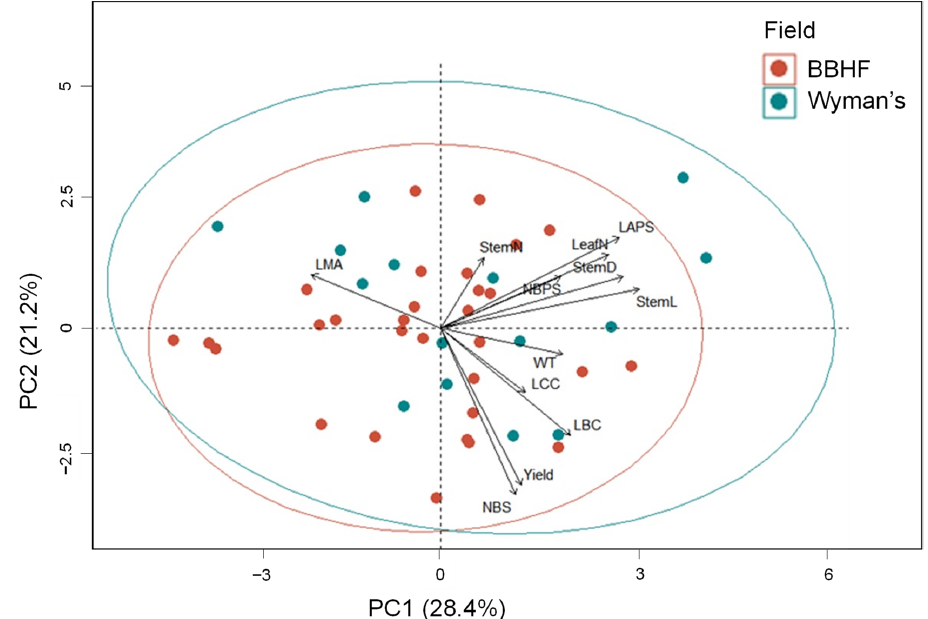
Figure 8. Principal Component Analysis (PCA) of mean values of studied common structural and functional traits. The red circle represents BBHF’s field, and the blue circle represents Wyman’s field mean trait values. For definitions of trait abbreviations, please see Table 1.